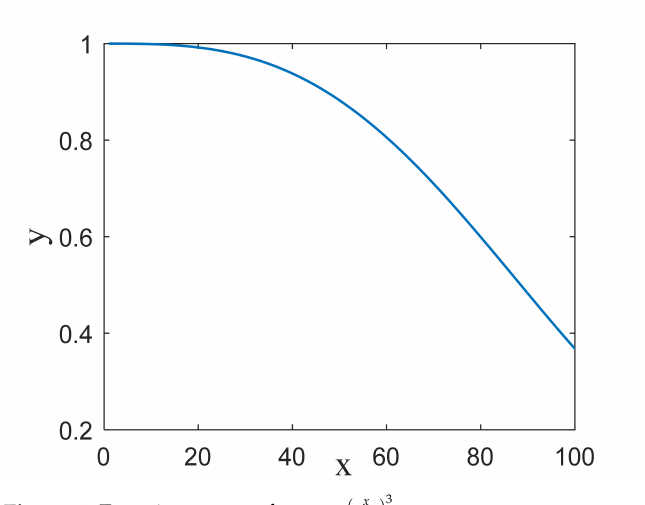
Figure 4. Function curve of y = e − ( x 100 ) 3